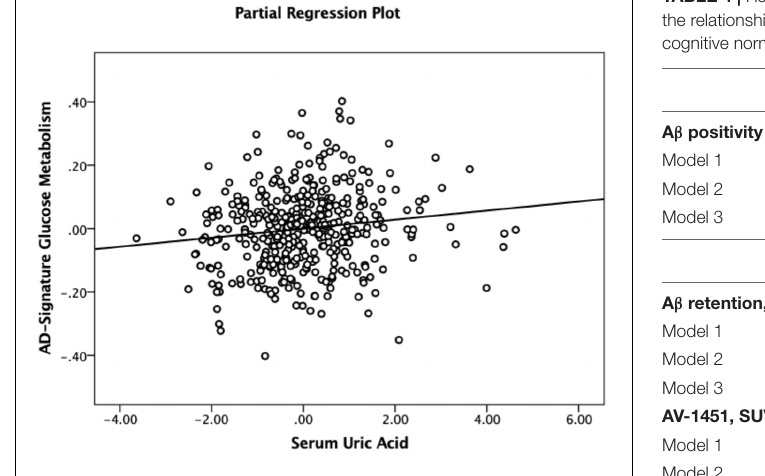
FIGURE 1 | Partial regression plot showing the relationship between serum uric acid and AD-signature cerebral glucose metabolism in non-demented participants. Multiple linear regression analysis was performed after adjusting for age, sex, education, apolipoprotein ε 4, vascular risk score, clinical diagnosis, serum albumin, body mass index, smoking status, and alcohol intake status. Abbreviations: AD, Alzheimer’s disease.